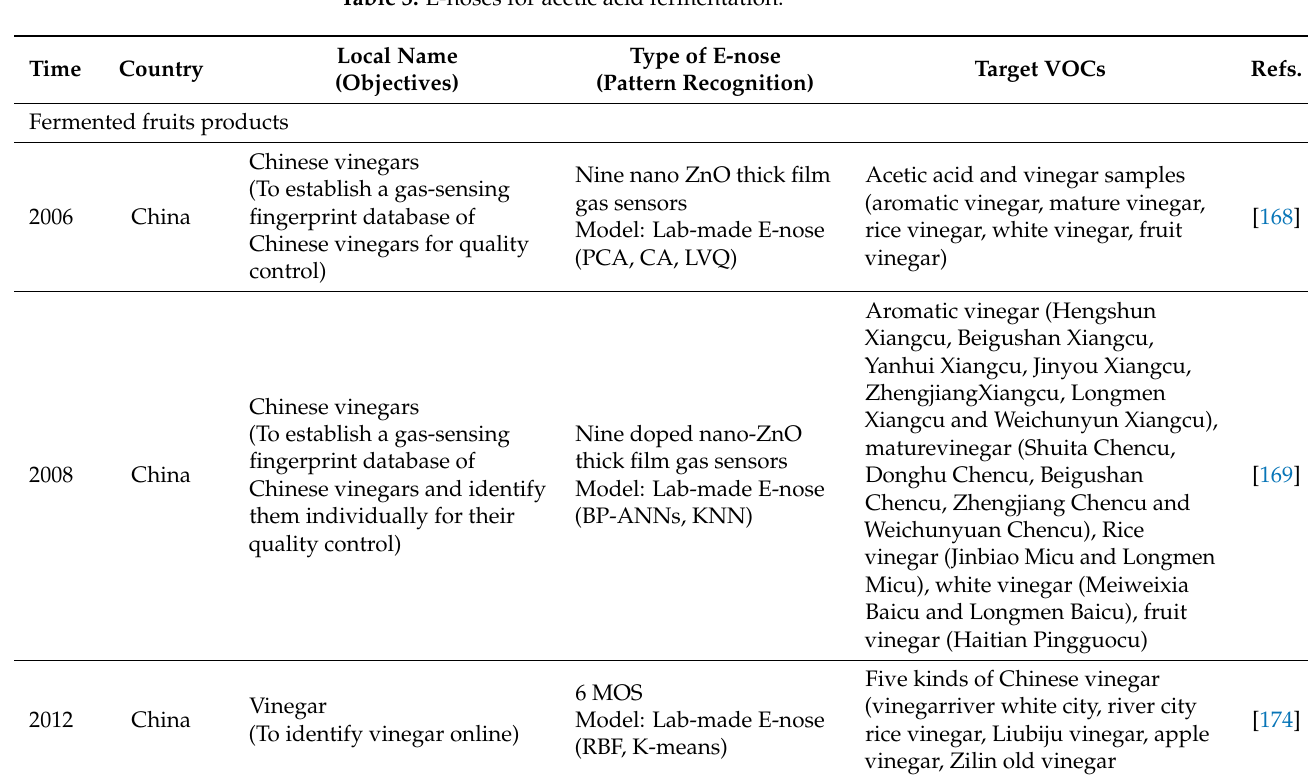
Figure 6. Schematic diagram of IoT E-nose system [172]. Table 3. E-noses for acetic acid fermentation.